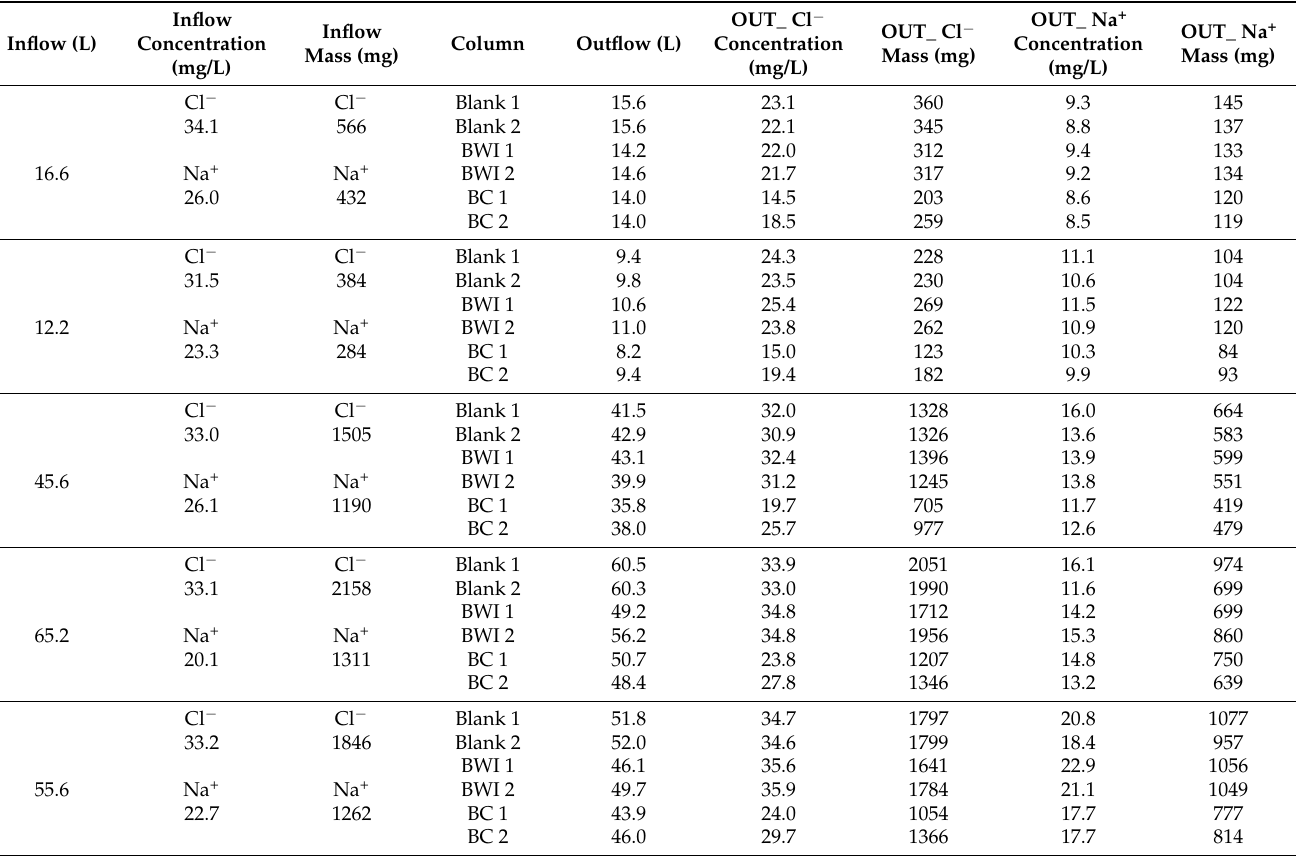
Table 4. Inflow and outflow characteristics for low-level deicing salt concentration of synthetic stormwater runoff (Blank: no plants; BWI: Blue Wild Indigo; BC: Broadleaf Cattail).